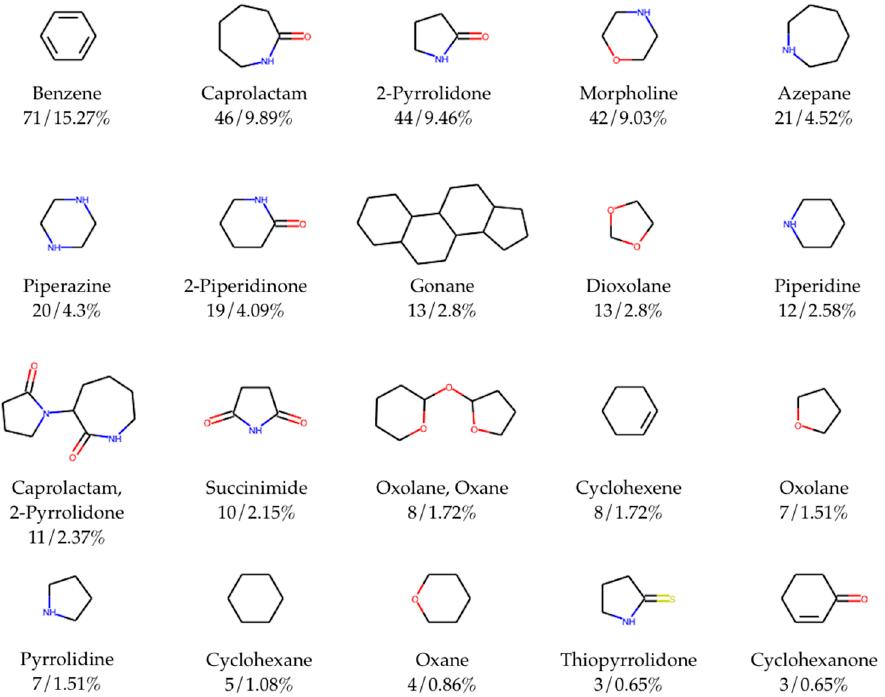
Figure 4. Top 20 most frequent chemical scaffolds (with trivial names of scaffolds/ring systems comprising fragments, total counts, frequency) in CPE-DB. Total number of identified unique scaffolds is 97 out of 465 compounds with cycles.